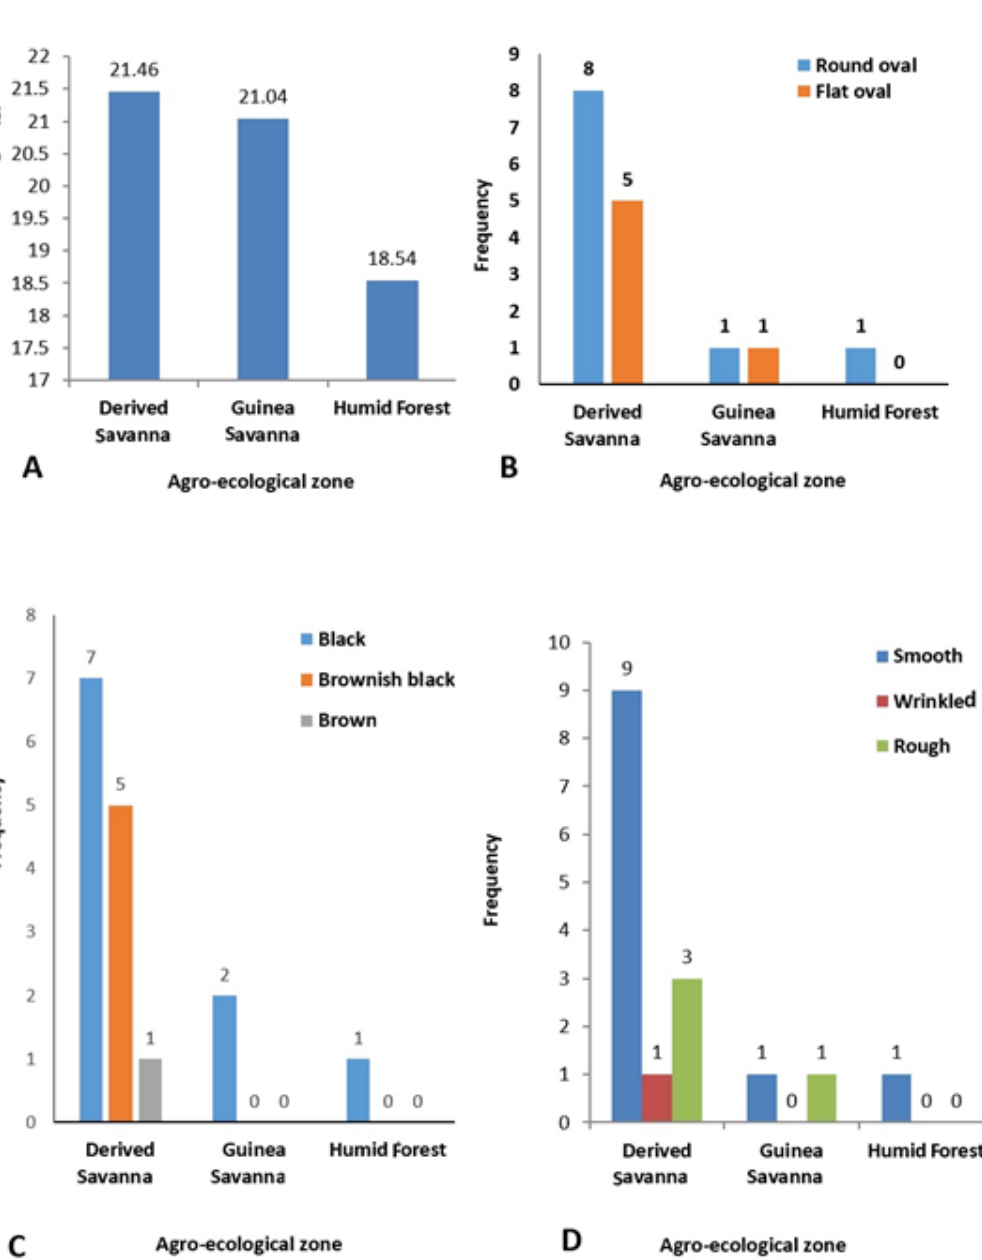
(Table 4). The dendrogram grouped the sixteen acces-